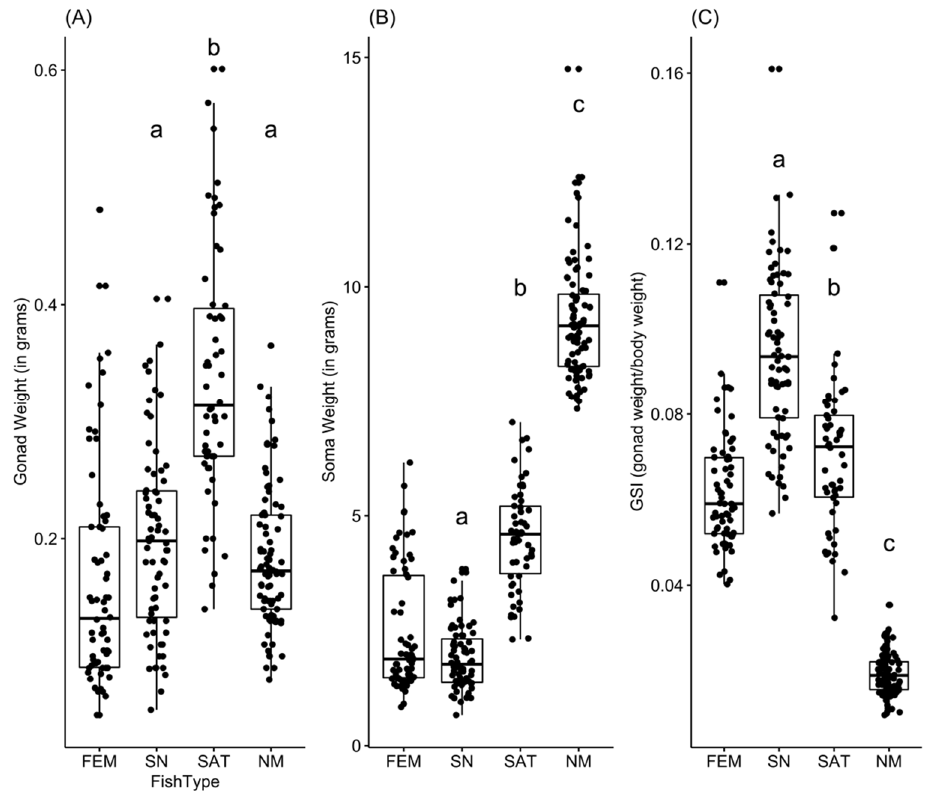
Figure 1. Alternative reproductive types differ in gonad weight and soma weight, as well as variation in gonad weight. On the x-axis: FEM = females, SN = sneaker males, SAT = satellite males, NM = nesting males. ( A ) Absolute gonad weight differs among types; satellite males have the largest absolute testes. ( B ) Absolute soma weight differs among types; sneakers are smaller than satellite males and satellite males are smaller than nesting males. ( C ) Gonadosomatic index differs among male types. Female data for all three variables are included for graphical comparison, but were not included in the statistical analyses. Lower case letters represent the male types that are significantly different from one another based on ANOVA followed by Tukey post hoc pairwise comparison tests. Alternative male types also differ significantly in GSI (sneaker > satellite > nesting male relative gonad weight). See text for full statistical methods and results.